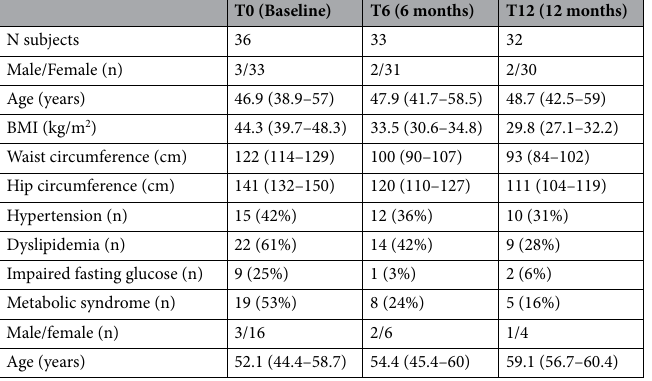
Table 1. Patients’ characteristics. Continue variables are expressed as median (IQ range). Discrete variables are reported as number of subjects